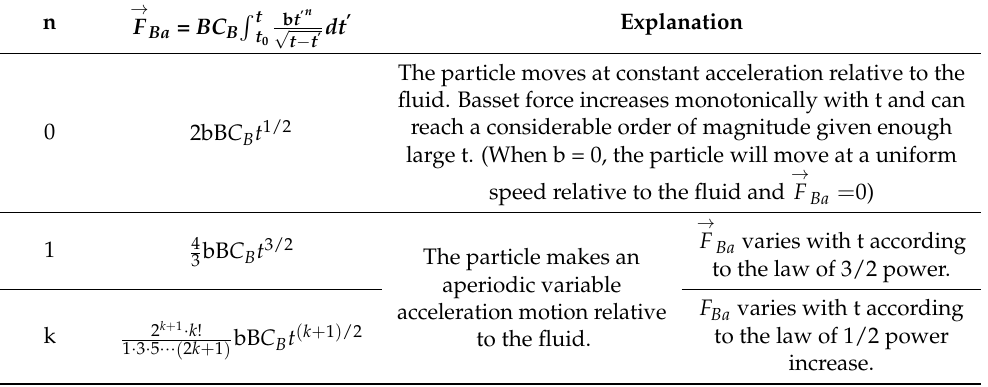
Table 1. Different conditions considering the value of